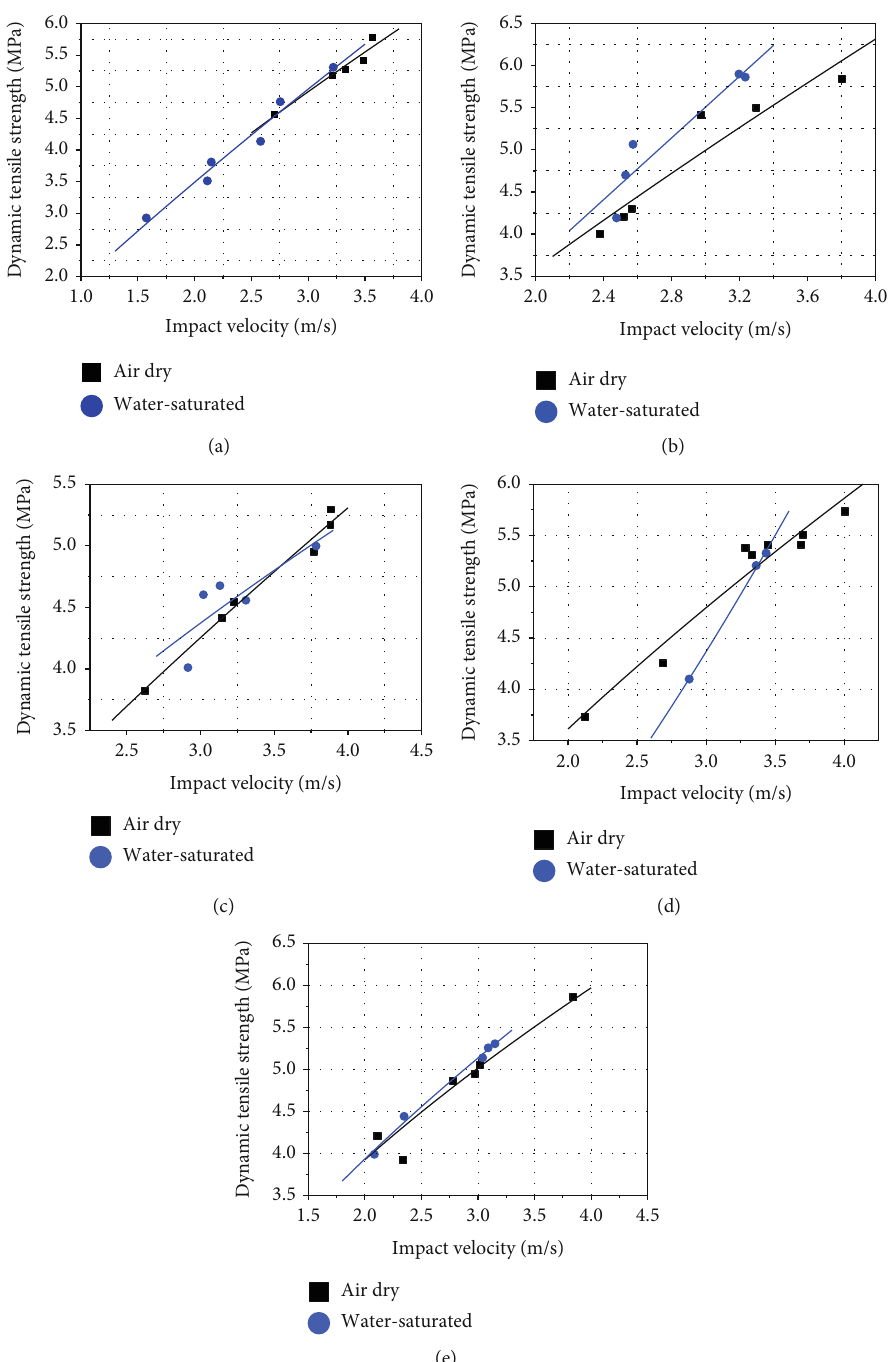
Figure 6: Comparison of relationship between dynamic tensile strength and impact velocity of coal rock specimens in natural state and water- saturated state. (a) θ = 0 ° . (b) θ = 22 : 5 ° . (c) θ = 45 ° . (d) θ = 67 : 5 ° . (e) θ = 90 °